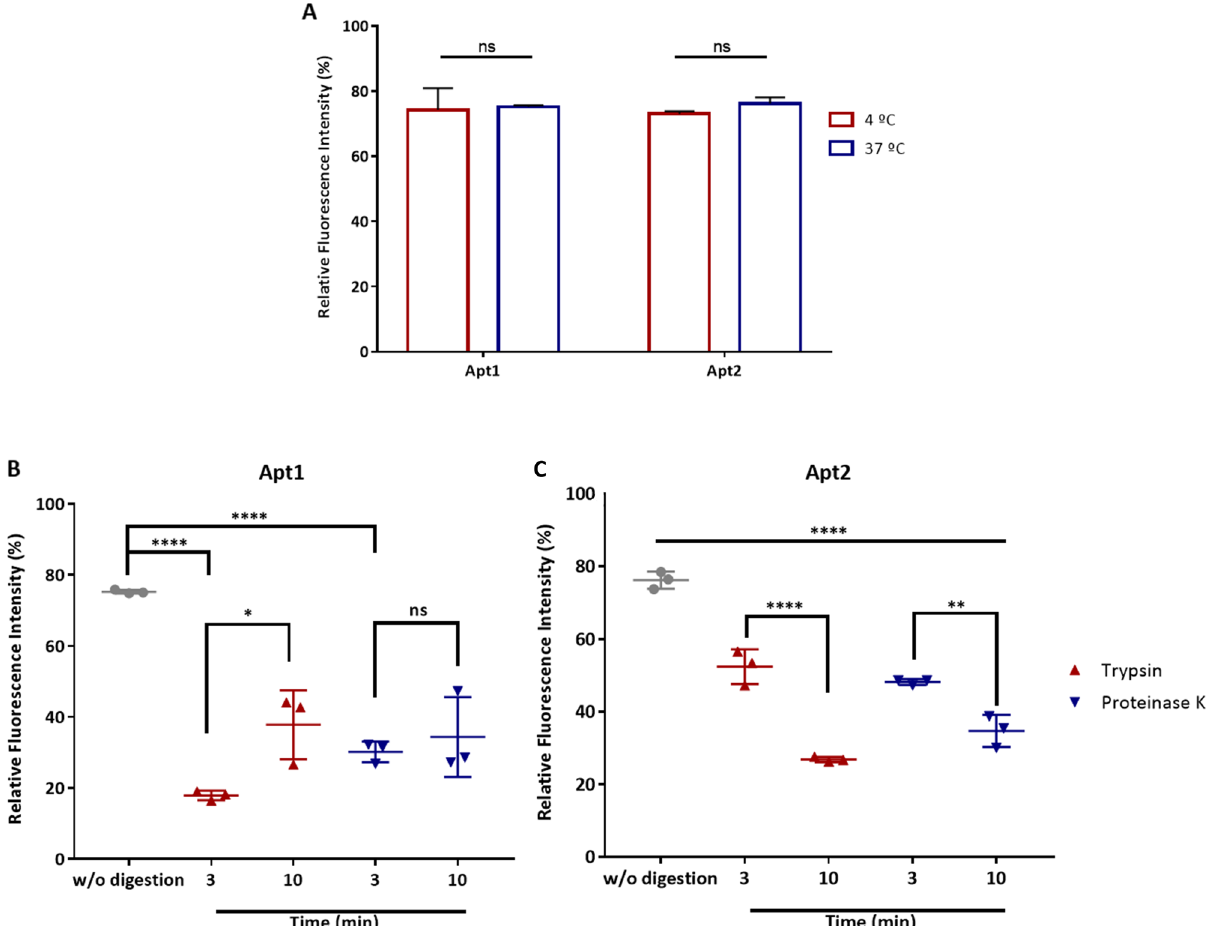
Figure 4. Binding characterization of Apt1 and Apt2 aptamers to MDA-MB-231 cells. ( A ) Effect of incubation temperature on the binding ability of Apt1 and Apt2 in MDA-MB-231 cells. The cells were incubated with FAM-labeled Apt1 and Apt2 at 4 °C or 37 °C and analyzed by flow cytometry. ( B ) Binding ability of aptamers Apt1 and Apt2 with MDA-MB-231 cells treated with trypsin or proteinase K. The cells were treated with trypsin or proteinase K at 37 °C for 3 or 10 min and then incubated with FAM-labelled Apt1 or Apt2, respectively. The binding ability of FAM-labelled Apt1 and Apt2 was analyzed by flow cytometry. All data are expressed as the mean ± SD of three independent experiments. One-way ANOVA indicates statistically significant differences within the group assessed by Tukey post-test and denoted as follows: ****ρ ≤ 0.0001, **ρ ≤ 0.01, *ρ ≤ 0.1 and ns ρ >